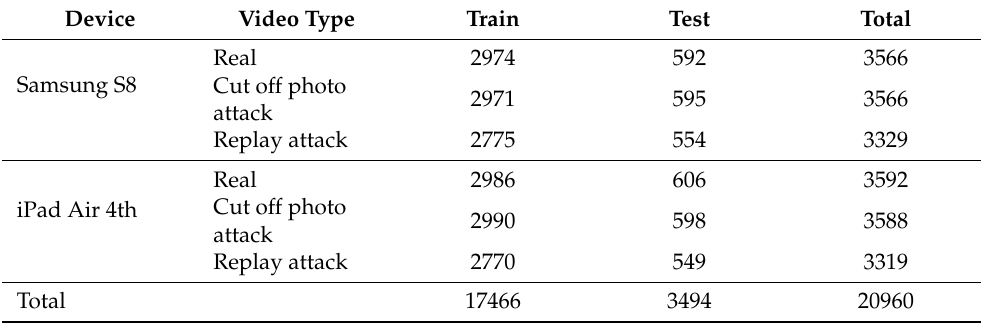
Table 1. Number of clips for each case.